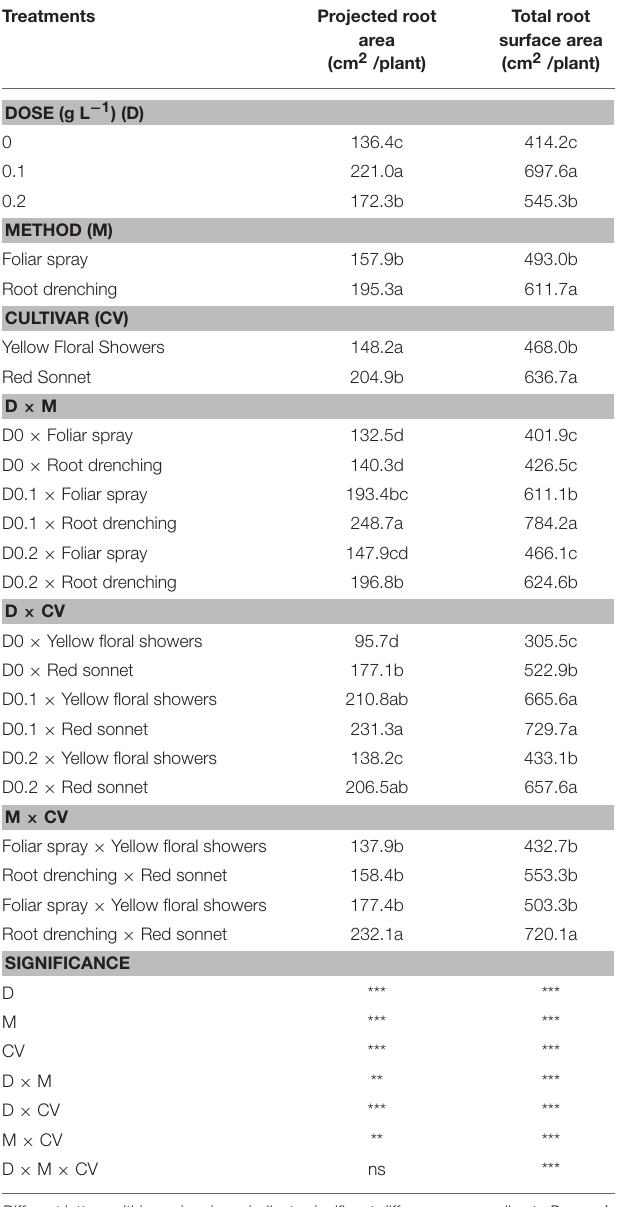
TABLE 5 | Main and interaction effects of biostimulant dose, application method and cultivar for projected and total root surface area in snapdragon plants. Treatments